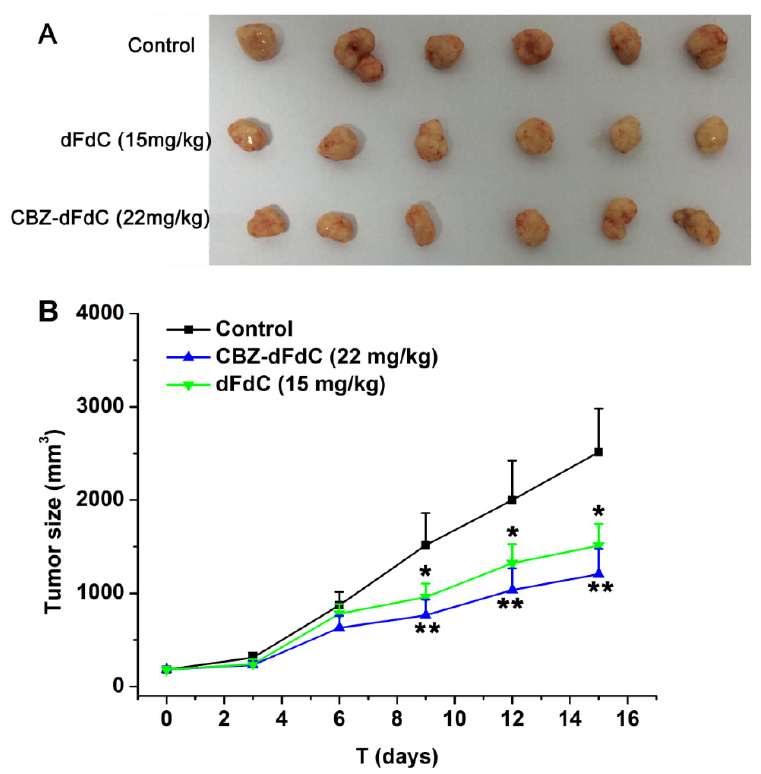
Figure 7. The measured anti-tumor e ff ect after Cbz-dFdC administration (i.g., 22 mg / kg) and dFdC administration (i.p., 15 mg / kg) for 15 days, ( A ) tumor image; and ( B ) tumor size. The control group is represented by the solid black line. The dose of Cbz-dFdC (22 mg / kg) is represented by the blue line. The dose of dFdC (15 mg / kg) is represented by the green line. The Cbz-dFdC and dFdC groups were compared with the control group (* p < 0.05 and ** p < 0.01).